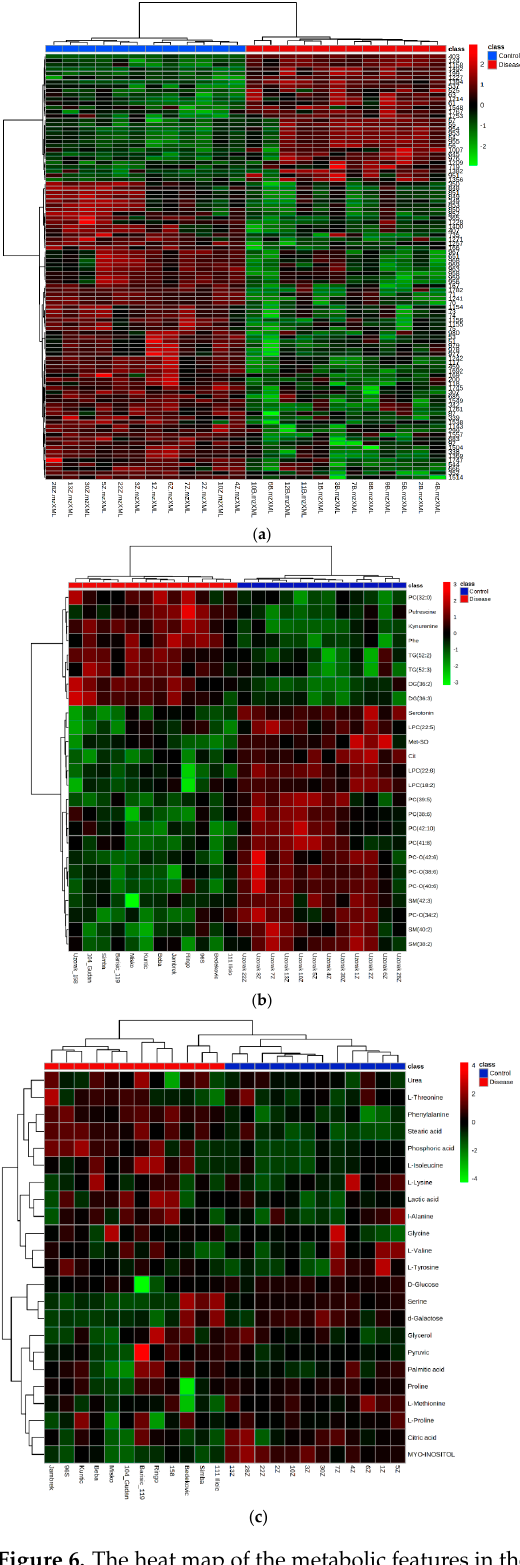
Figure 6. The heat map of the metabolic features in the untargeted LC-MS metabolomics ( a ), targeted LC-MS metabolomics ( b ), and GC-MS metabolomics ( c ). Red color represents the increased level of each metabolite, while blue color represents the decreased level of each metabolite in dogs infected with B. canis versus control dogs. Blue panel-control samples, red panel-disease samples.